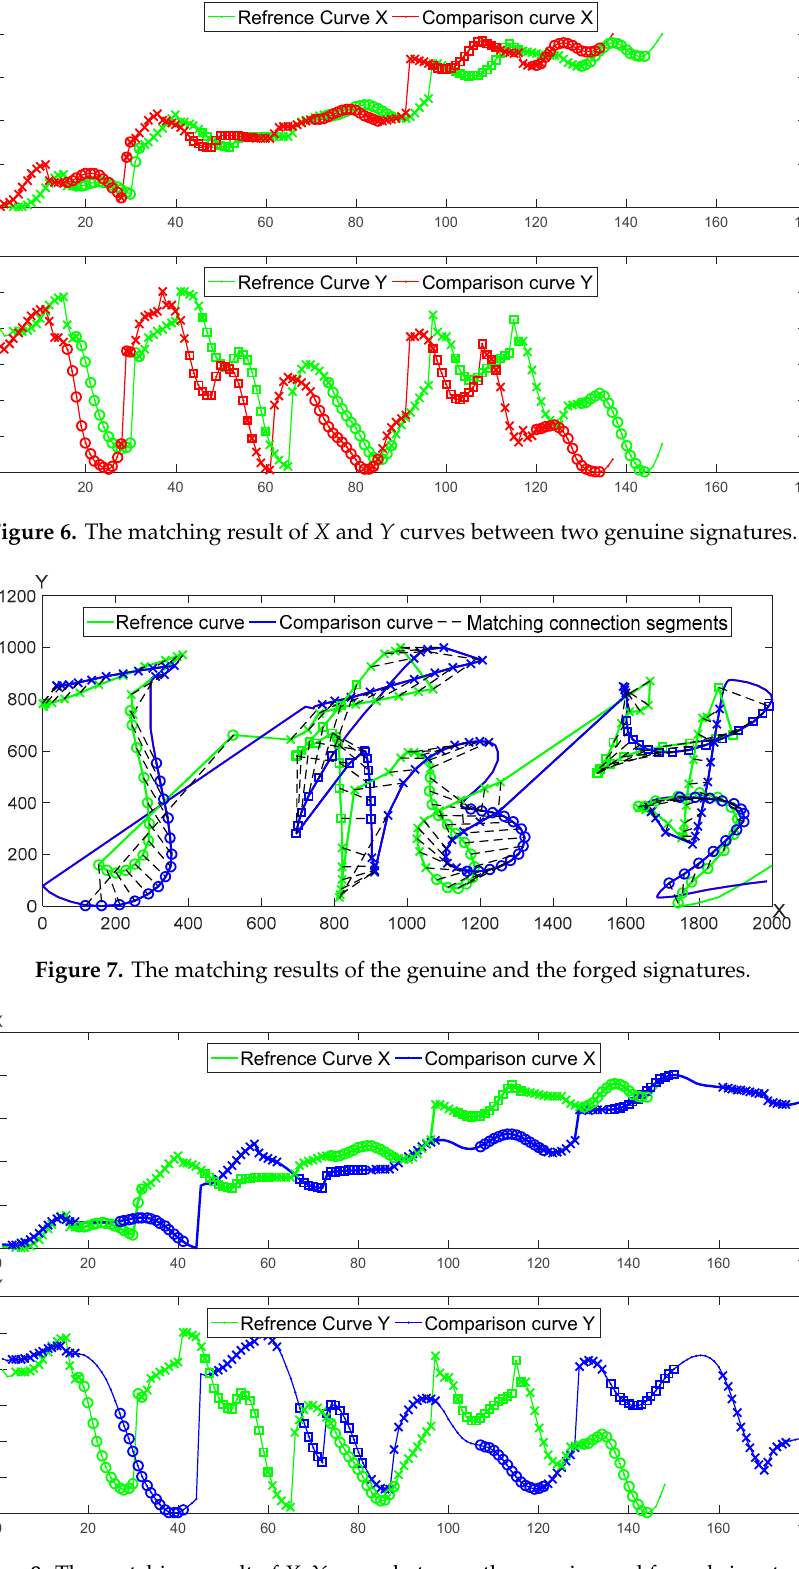
Figure 8. The matching result of X , Y curve between the genuine and forged signatures. The optimal segmentation matching results between three curves are shown in Tables 1 and